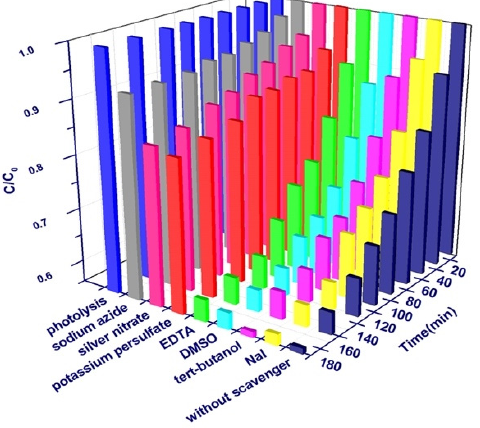
Figure 7. Effect of different radical scavengers (3 mmol/L) on the photodegradation of MB (5 ppm) CMO (1 mg/mL). C/C 0 ratio (C 0 is the initial concentration) vs. irradiation time.